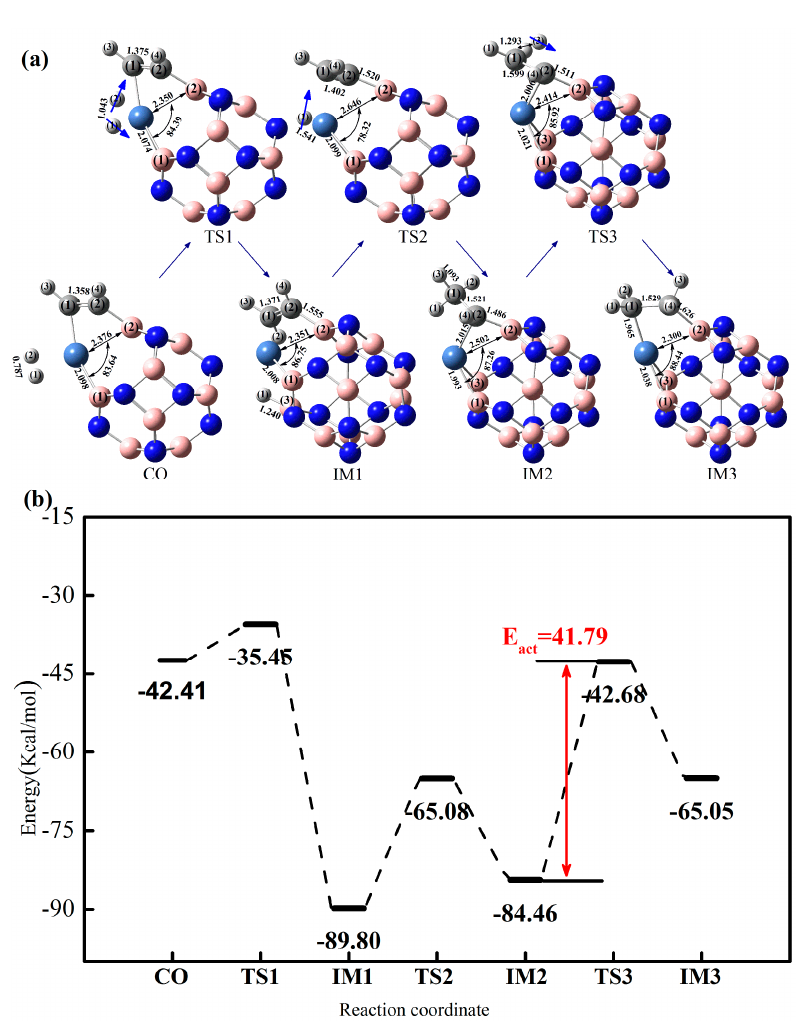
Figure 5. The reaction process and potential energy change for the different reaction pathways R3 of catalytic hydrogenation of acetylene to ethylene on B 12 N 11 Ni. ( a ) The structures of calculated hydrogenation reaction diagram for the B 12 N 11 Ni. ( b ) The reaction process and potential energy change of catalytic hydrogenation of ethylene to ethylene on the B 12 N 11 Ni. H atom is white; B atom is pink; C atom is grey; N atom is mazarine; Ni atom is blue.